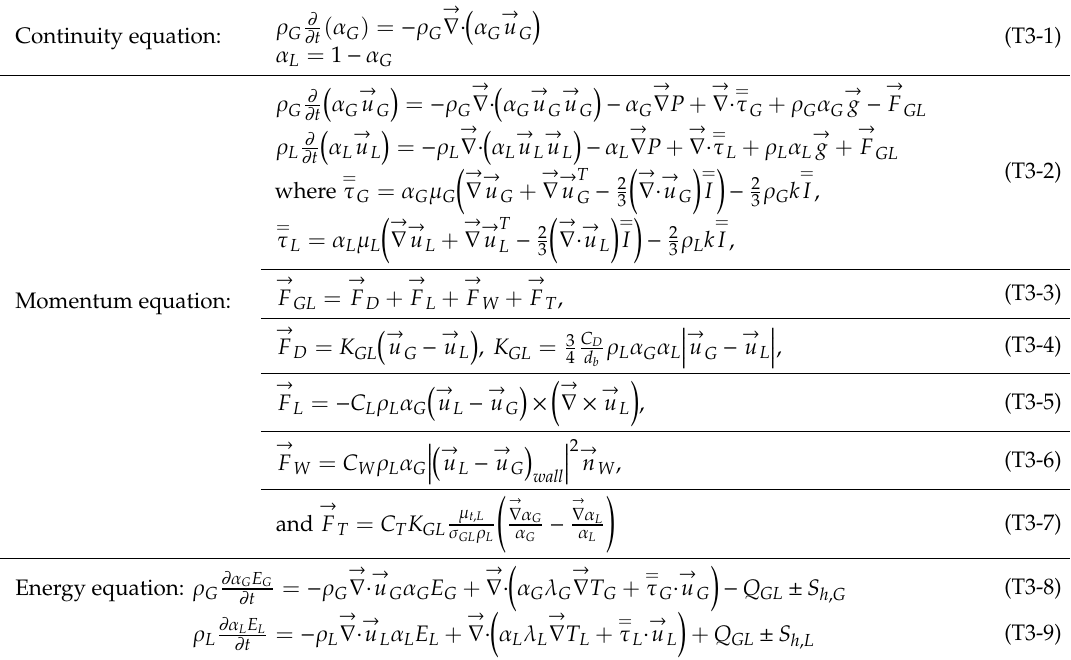
Table 3. Eulerian multiphase (EM)-CFD model for gas-liquid phase